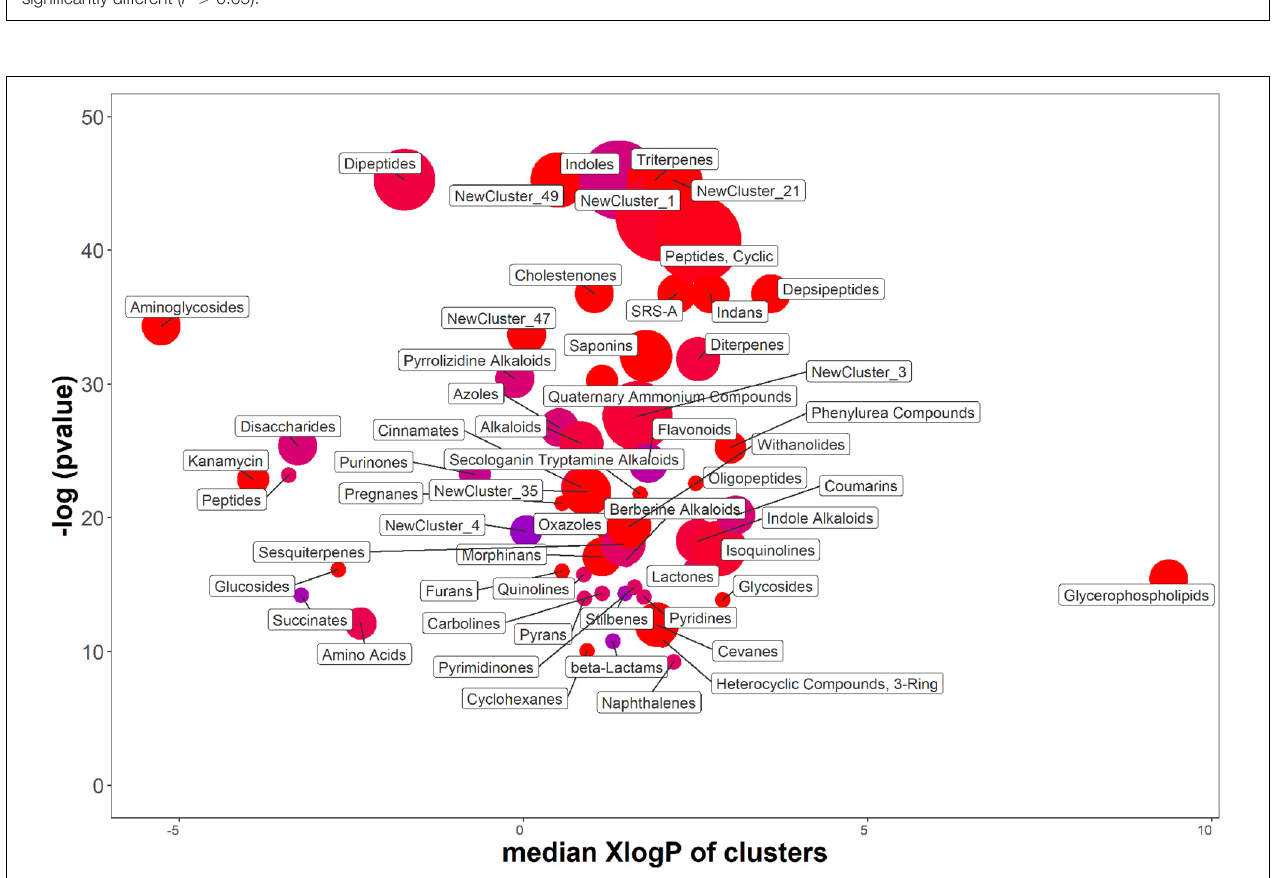
FIGURE 7 | ChemRich analysis of exometabolome of P. agglomerans C1 grown on YES vs. YEG medium. Red clusters associated with higher outcomes, and the blue ones associated with lower outcomes.